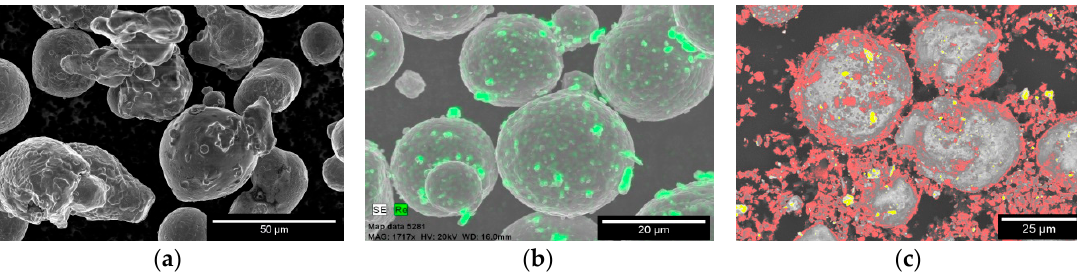
Figure 1. SEM and EDX micrographs of powders used for sintering process: ( a ) 100NiCr, ( b ) 99NiCr-1Re (green color refers to Re), ( c ) 90(99NiCr-1Re)-10Al 2 O 3 (yellow color refers to Re, and red-to Al 2 O 3 ). Table 1. Densities of the NiCr based materials sintered at 1050 ° C by SPS.